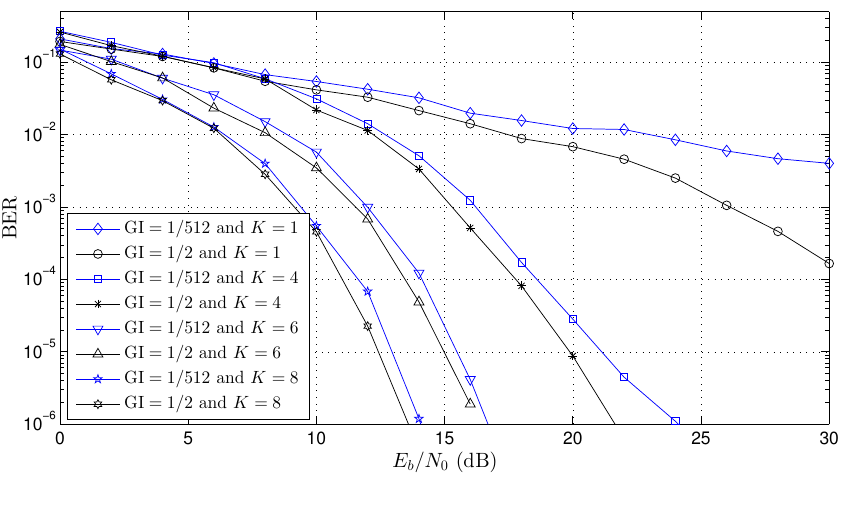
Figure 7. BER performance curve for Channel 2 (see Table